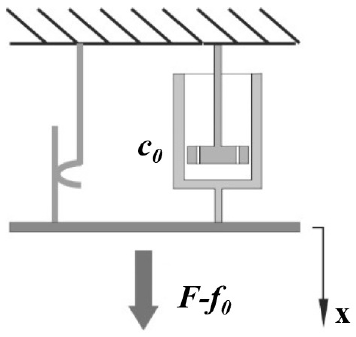
Figure 1. Scheme of the Bingham model.